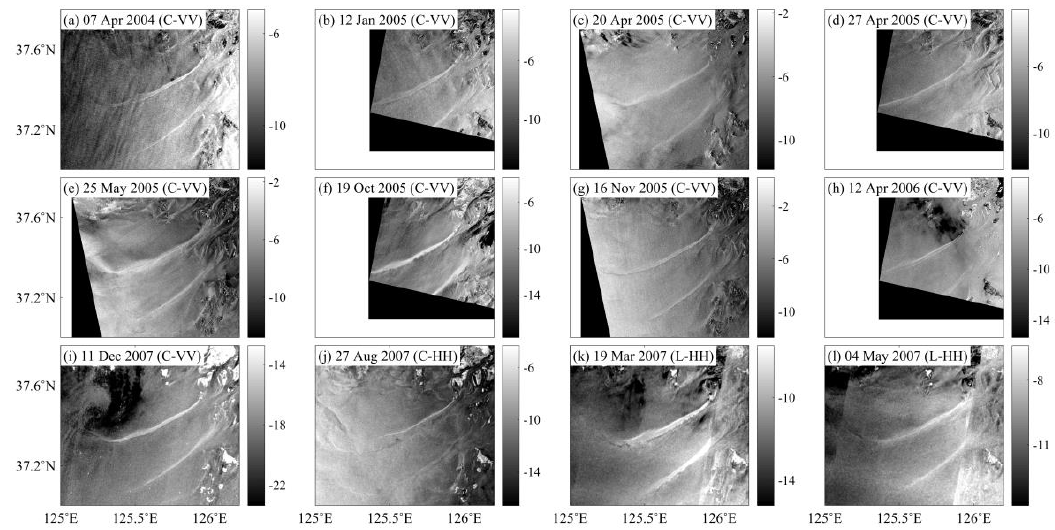
Figure 4. Sub-scenes of SAR images with dB units in the study area on ( a ) 7 April 2004, ( b ) 12 January 2005, ( c ) 20 April 2005, ( d ) 27 April 2005, ( e ) 25 May 2005, ( f ) 19 December 2005, ( g ) 16 November 2005, ( h ) 12 April 2006, ( i ) 11 December 2007, ( j ) 27 August 2007, ( k ) 19 March 2007, and ( l ) 4 May 2007. The images in ( a – i ), ( j ), and ( k , l ) were observed with C-band VV-polarization, C-band HH-polarization, and L-band HH-polarization, respectively.